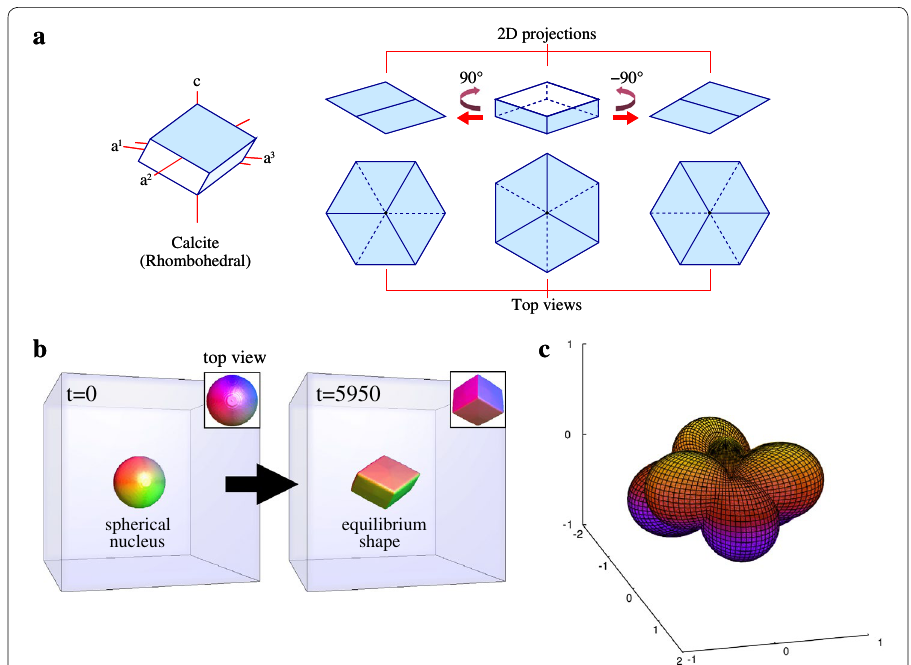
Fig. 1 a Illustration of the euhedral geometry of calcite crystal ( rhombohedron ) along with 2D projections and top views [adapted from open source Imperial College London (2013)]. b Verification of the faceted-type anisotropy for 3D numerical studies. An initial spherical nucleus (at t = 0 ) dispersed in liquid evolves to its equilibrium shape (at t = 5950 ) using the volume preservation technique. The entire domain sans the crystal is filled with liquid phase (in transparent blue ). The distinct colors of the facets are for the sake of visualization and represent the normal direction of different facets. c Polar ( spherical ) surface energy ( γ ) plot correspond- ing to the equilibrium